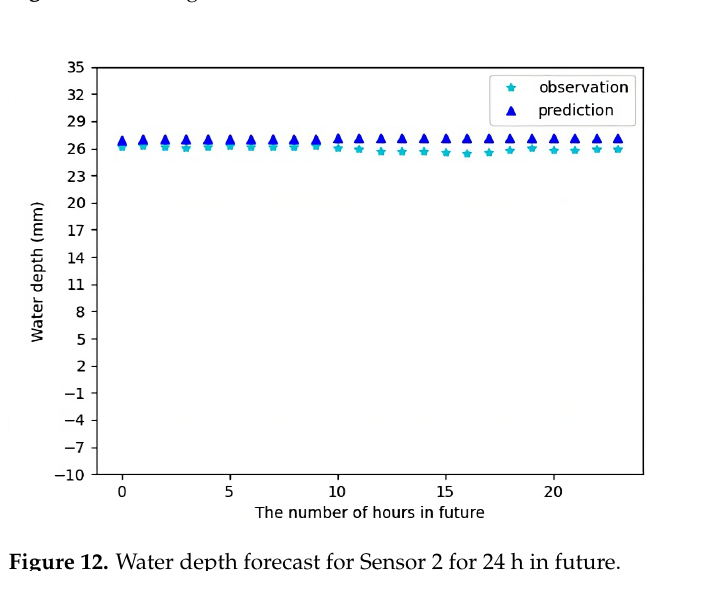
Figure 12. Water depth forecast for Sensor 2 for 24 h in future.